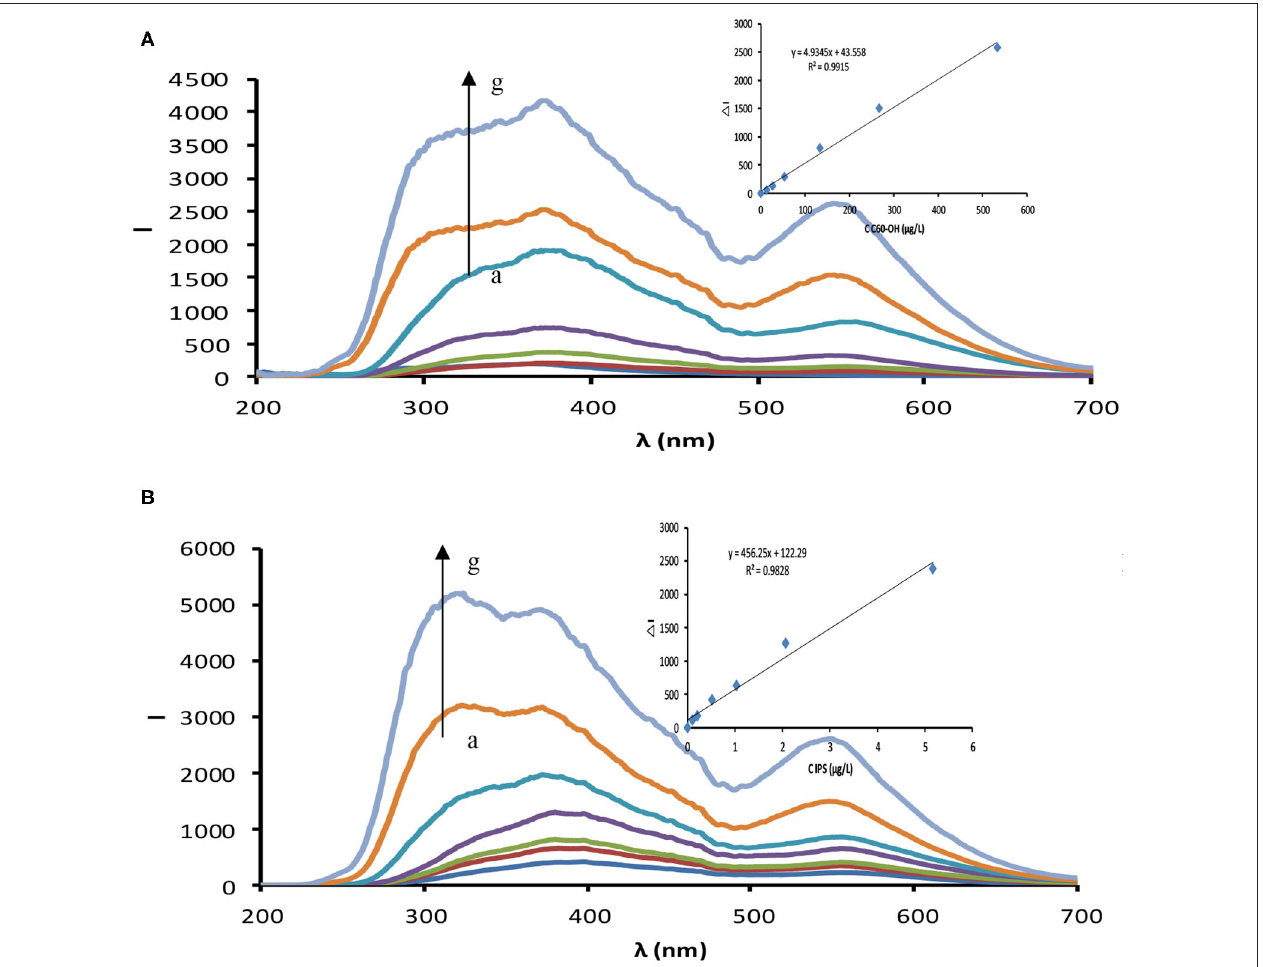
FIGURE 3 | RRS spectra. (A) C 60 OH–AgNO 3 -TSC catalytic system, (0, 13.33, 26.67, 53.33, 133.33, 266.67, 533.33 µ g/L) C 60 OH + 1.33 mmol/L AgNO 3 + 4.67 mmol/L TSC + 85 ◦ C + 21min + 3.33 × 10 − 7 mol/L VBB + 0.02 mol/L NaCl. (B) Apt–C 60 OH–AgNO 3 -TSC-IPS detection system, 20.67 nmol/L Apt + 266.67 µ g/L C 60 OH + (0, 0.1, 0.21, 0.52, 1.03, 2.07, 5.17 µ g/L) IPS + 1.33 mmol/L AgNO 3 + 4.67 mmol/L TSC + 85 ◦ C + 21min + 3.33 × 10 − 7 mol/L VBB + 0.02 mol/L